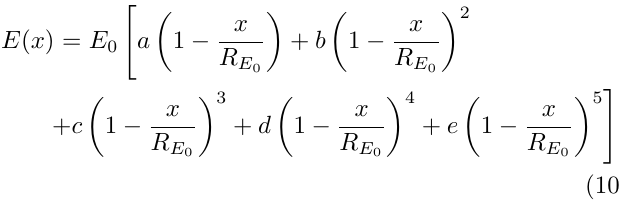
Table 2. Average energy required to produce an ion pair in different gas for fission